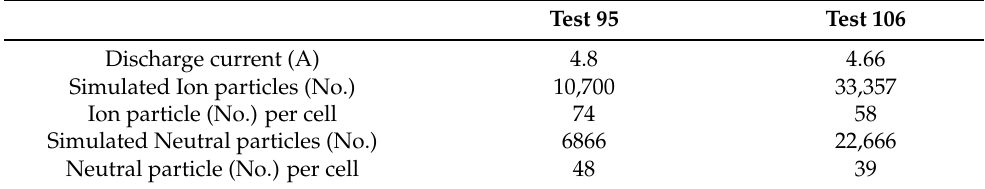
Table 3. SPT-100 discharge simulation: time-average discharge current and number of simulated macro-particles (neutrals and ions). The average numbers of particles per cell have been reported.